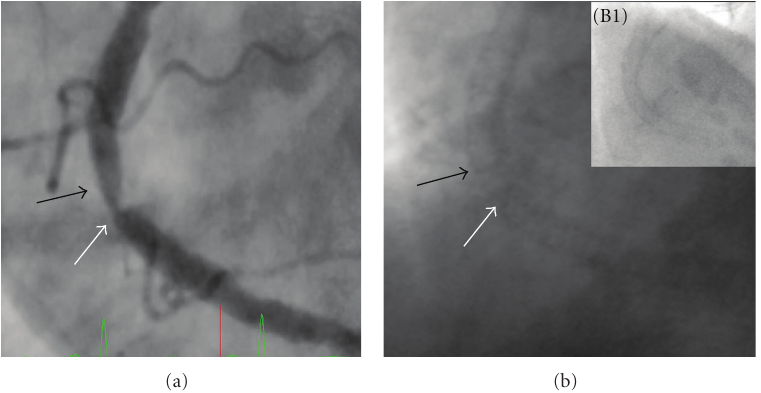
Figure 2: Focal in-stent restenosis of the mid-right coronary artery (a). Complete stent fracture with a clear separation of the stent struts (b). Imaging of the Xience V stent confirming no separation between struts at the original stent procedure (B1).